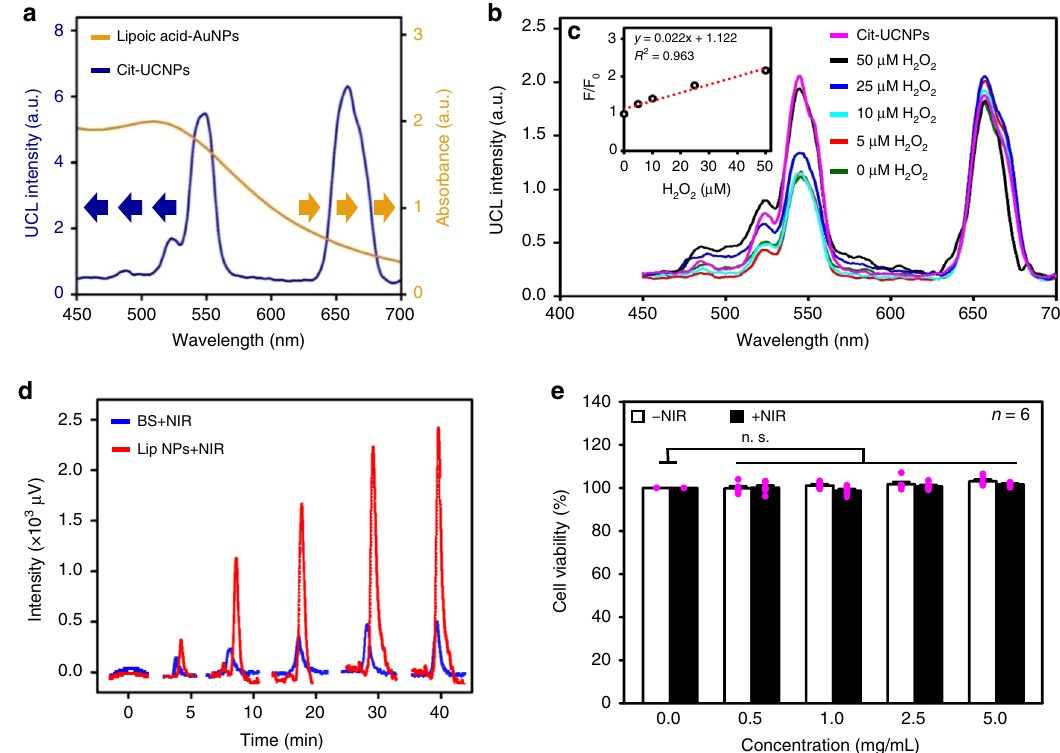
Fig. 5 H 2 O 2 detection, H 2 generation, and cytotoxicty. a Fluorescence spectrum of Cit-UCNPs irradiated at 980 nm and UV/vis absorbance of AuNPs. b Fluorescence excitation spectra of nanocomplexes following incubation with various concentrations of H 2 O 2 for 30min. c Linear correlation curve of green UCL ( F / F 0 ) intensity against concentration of H 2 O 2 . d Cumulative amount of gaseous H 2 generated from BS or Lip NPs under NIR laser irradiation. e Cell viability of RAW264.7 cells incubated with various concentrations of Lip NPs. Data in ( e ) are represented as mean± SE. P values were determined using the two-tailed unpaired Student ’ s t test. n.s. not signi fi cant. Each pink dot represents one observed data point. Source data are provided as Source Data fi